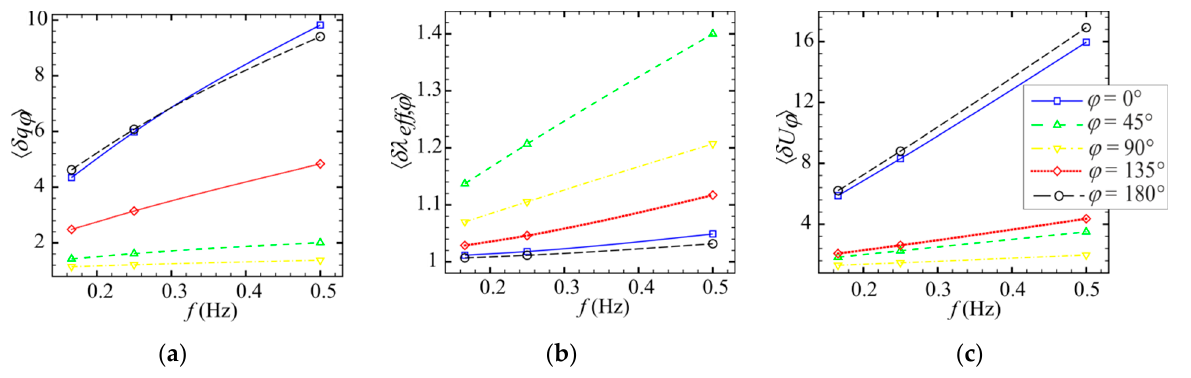
Figure 11. The effect of pulsations on the local flow and heat transfer characteristics at A / D = 3. ( a ) The variation in the heat flux ratio δ q φ = q φ , p / q φ , st with f . ( b ) Variation in the effective thermal conductivity ratio δλ eff , φ = λ eff , φ , p / λ eff , φ , st with f . ( c ) Variation in the velocity ratio δ U φ = U φ ,, p / U φ ,, st with f.